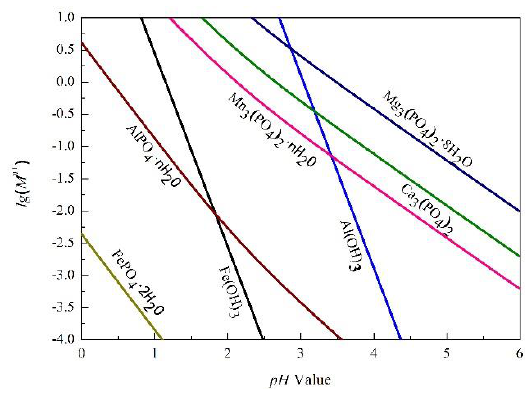
Figure 4. Enlarged view of lg(M n+ )-pH relationship.